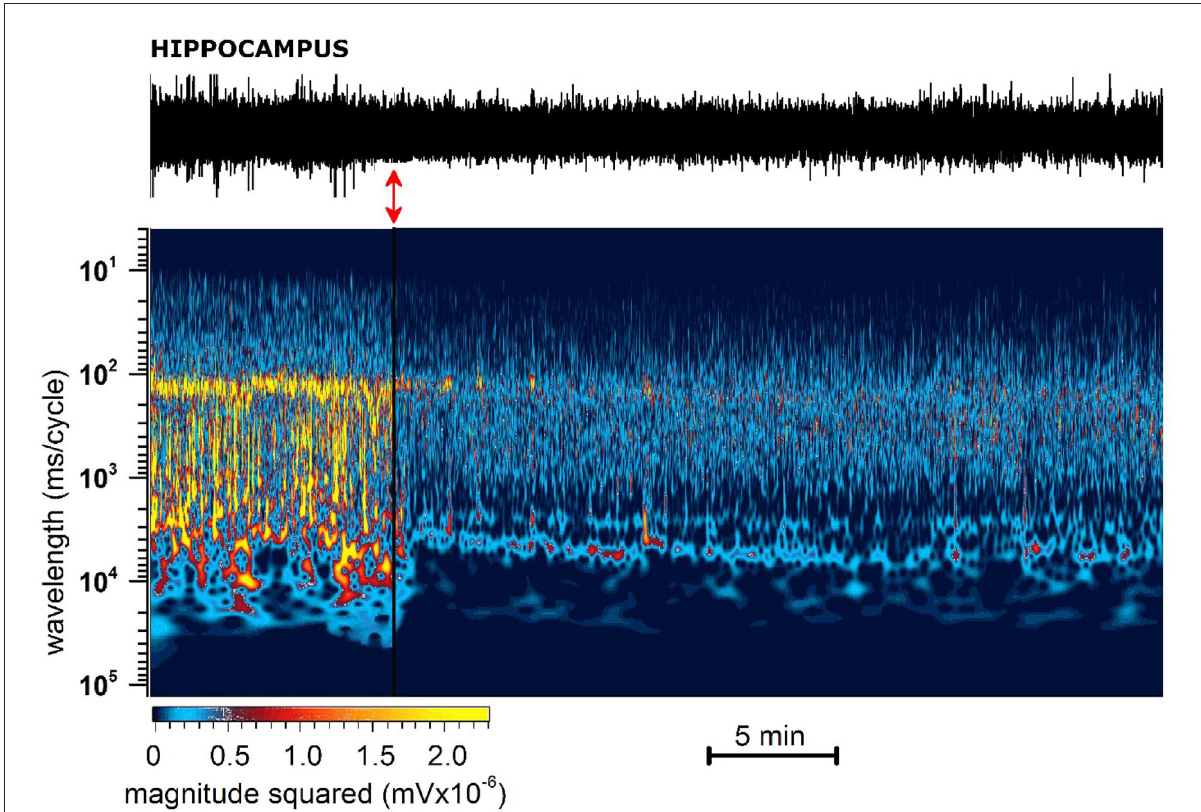
FIGURE8 Representative 40min recording of hippocampal EEG with JWH-073 administration and relative spectrogram. (Top) Raw EEG with JWH-073 application (red double headed arrow). (Bottom) Corresponding spectrogram correlating time (X) vs. wavelength (Y) and power (color scale). Wavelength ranges from 0.05 to 150Hz (bottom to top) . Color power scale (below X scale), with power magnitude increasing from left to right (smallest to highest values = darker to lighter colors). Soon after JWH administration is visible a radical and fast modification of the EEG spectrogram by global steady fading of colors toward dark and